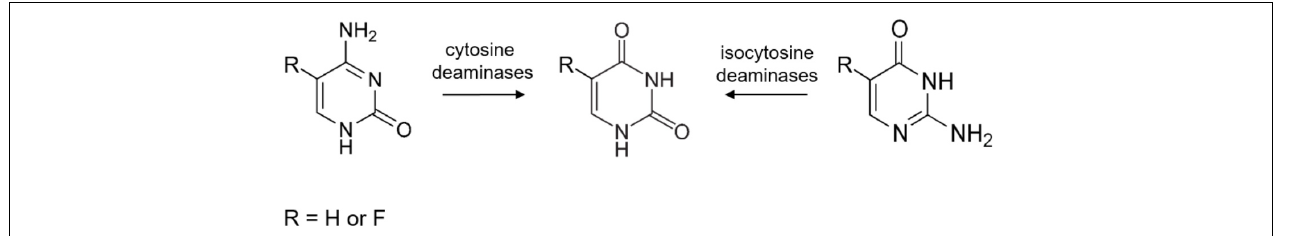
FIGURE 1 | A schematic representation of the classical cytosine deaminase (CD) and the predicted isocytosine deaminase substrates and products.